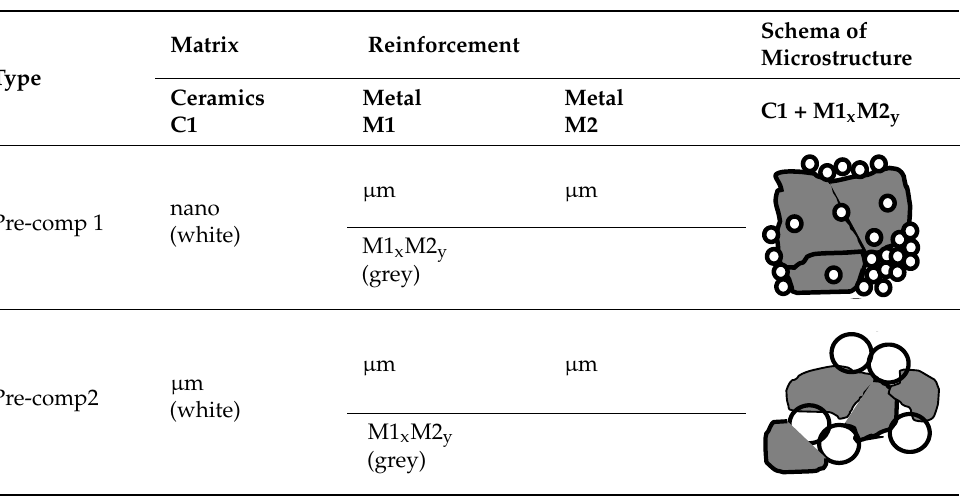
Table 4. Types of microstructures of ceramic–metal composites fabricated by consolidation of pow ‐ ders, one ceramic and pre ‐ composite powder with various variants of ceramics powder size and geometrical schemas.